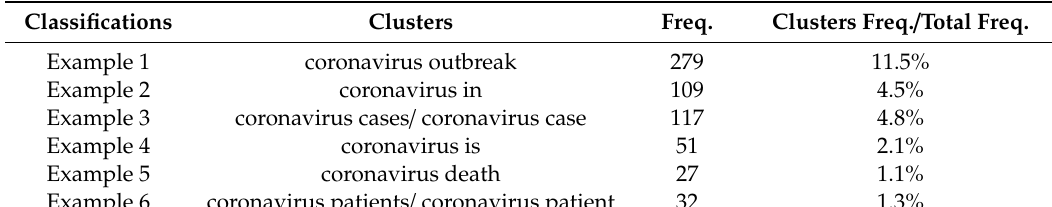
Table 10. Retrieved data from the top 30 clusters list.